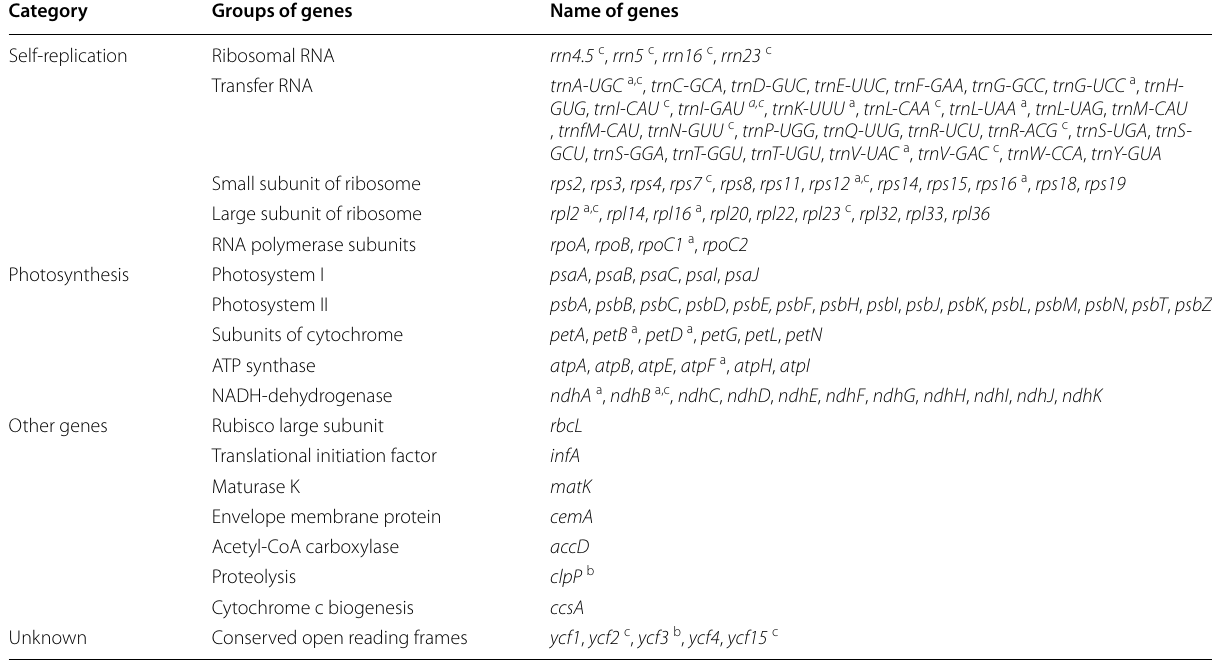
Table 2 List of the annotated genes in the chloroplast genomes of Veronicastrum wulingense